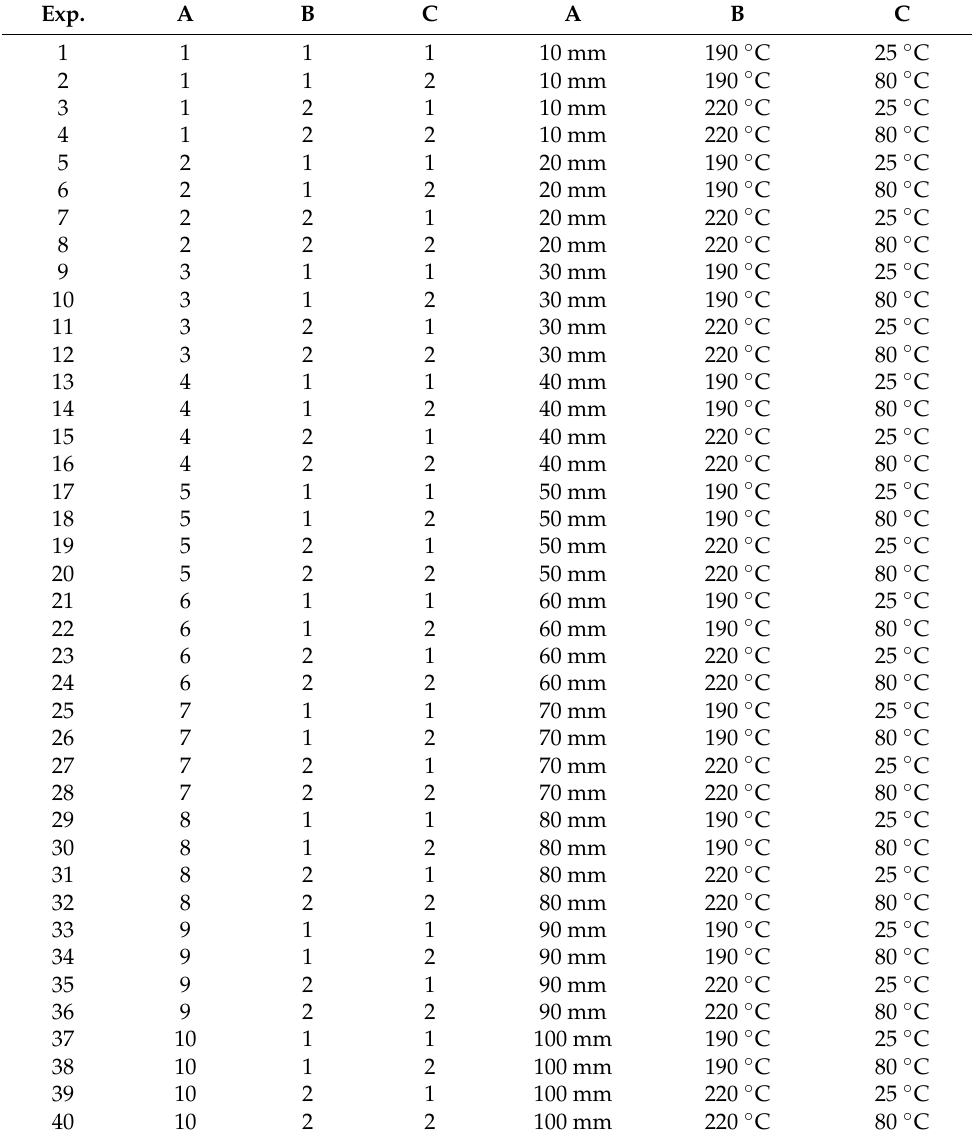
Table 4. Design of experiment for resistance